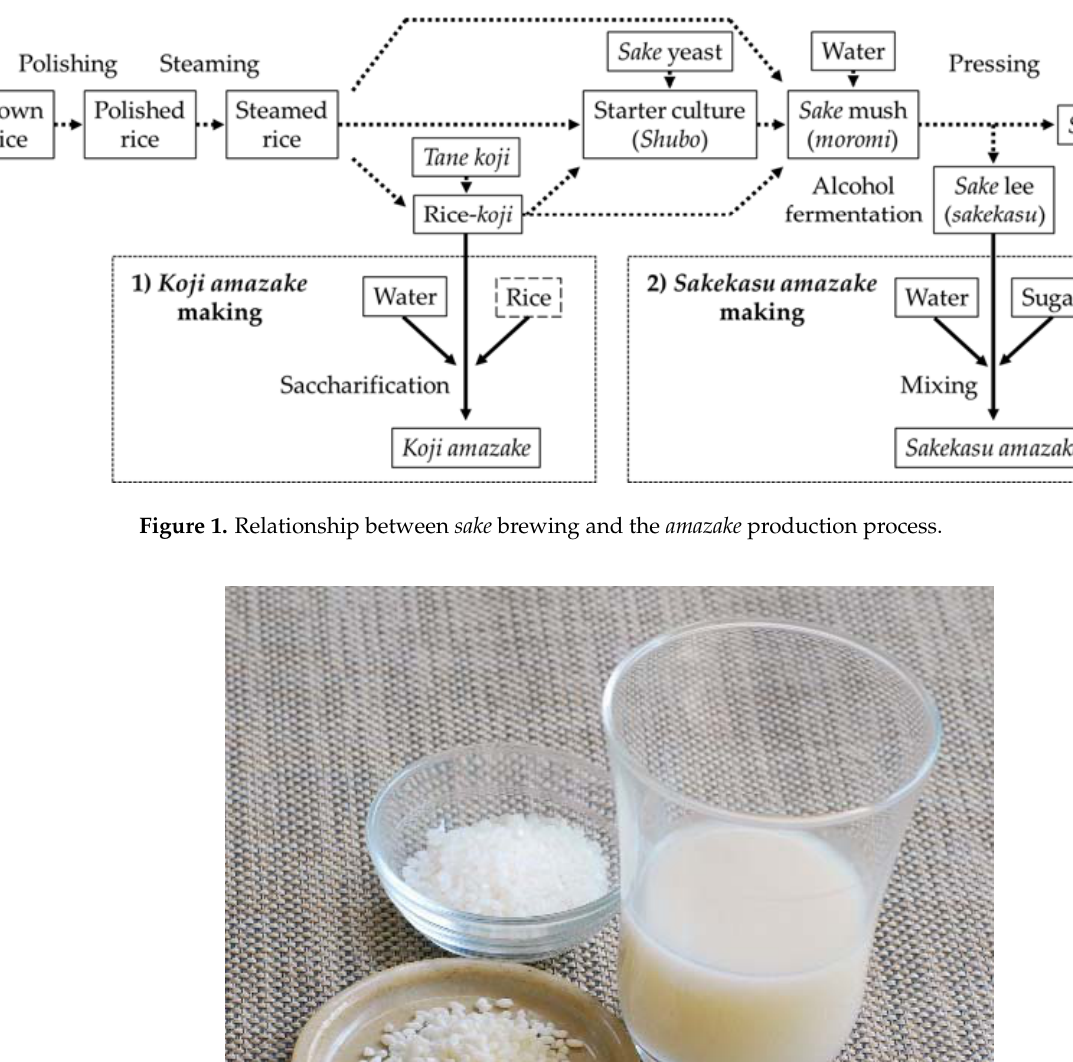
Figure 3. Koji amazake peddler in the Edo period [3]. 2. Ingredients Examples of the general nutritional components of koji amazake and sakekasu amazake are shown in Table 1. Carbohydrates are the most abundant nutritional component of both amazakes , but their contents are different. Most of the carbohydrates in koji amazake are glucose derived from rice starch, which is broken down by α -amylase and glucoamylase secreted by A. oryzae , as described previously herein. Furthermore, various oligosaccha- rides, mainly glucooligosaccharides, are produced by the transglycosylation activity of α - glucosidase, including trehalose (Glc( α 1-1)Glc), kojibiose (Glc( α 1-2)Glc), nigerose (Glc( α 1-3)Glc), maltose (Glc( α 1-4)Glc), isomaltose (Glc( α 1-6)Glc), sophorose (Glc( β 1- 2)Glc), and gentiobiose (Glc( β 1-6)Glc) (disaccharides), as well as maltotriose (Glc(